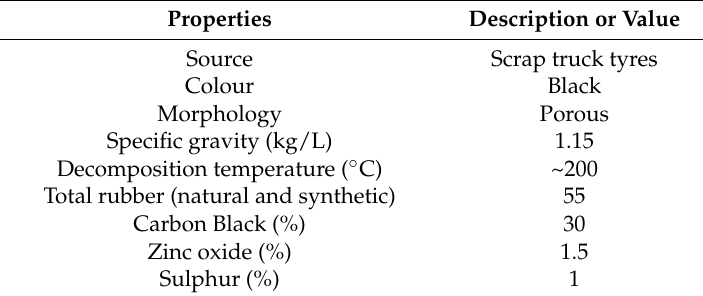
Table 3. Basic properties of CRM.